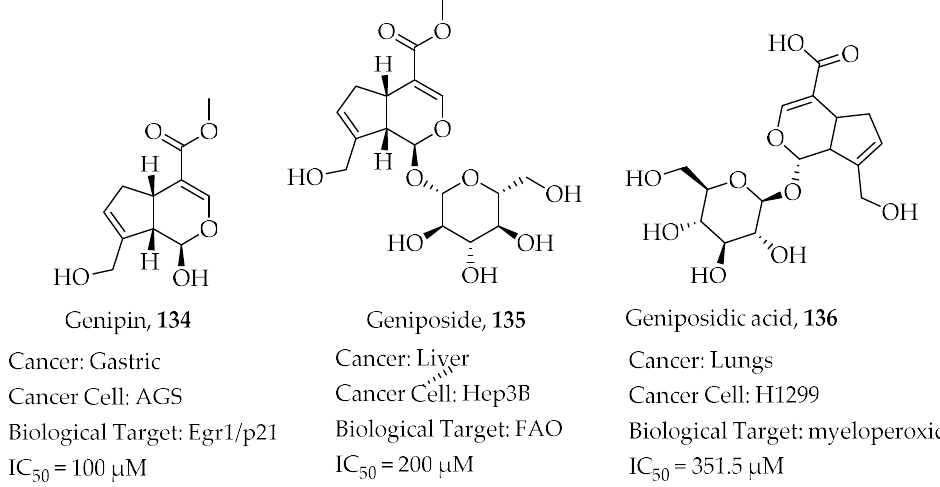
Figure 27. Structure of the iridoid glycosides Genipin, Geniposide and Geniposidic acid with a summary of their biological activity towards selected cancer targets.